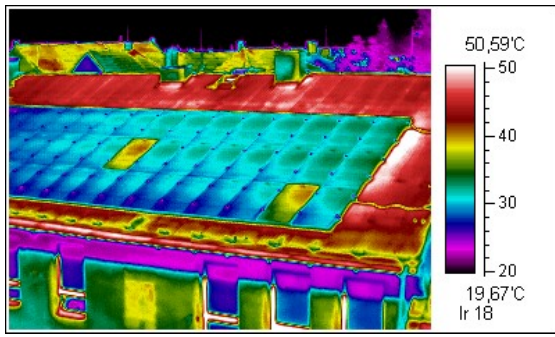
Figure 5. Defective panels identified by IRT analysis